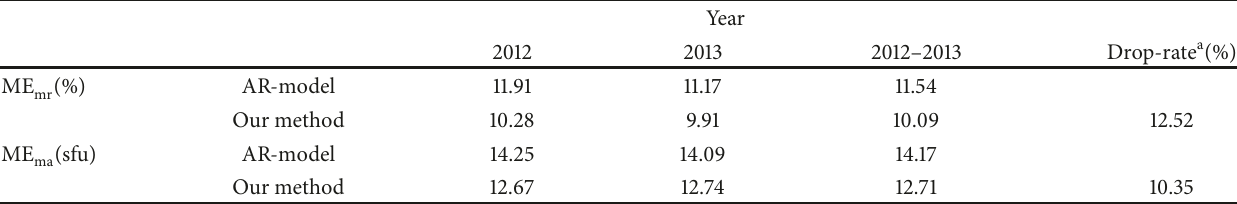
Table 2: The ME ma and ME mr values of AR-model and our method during